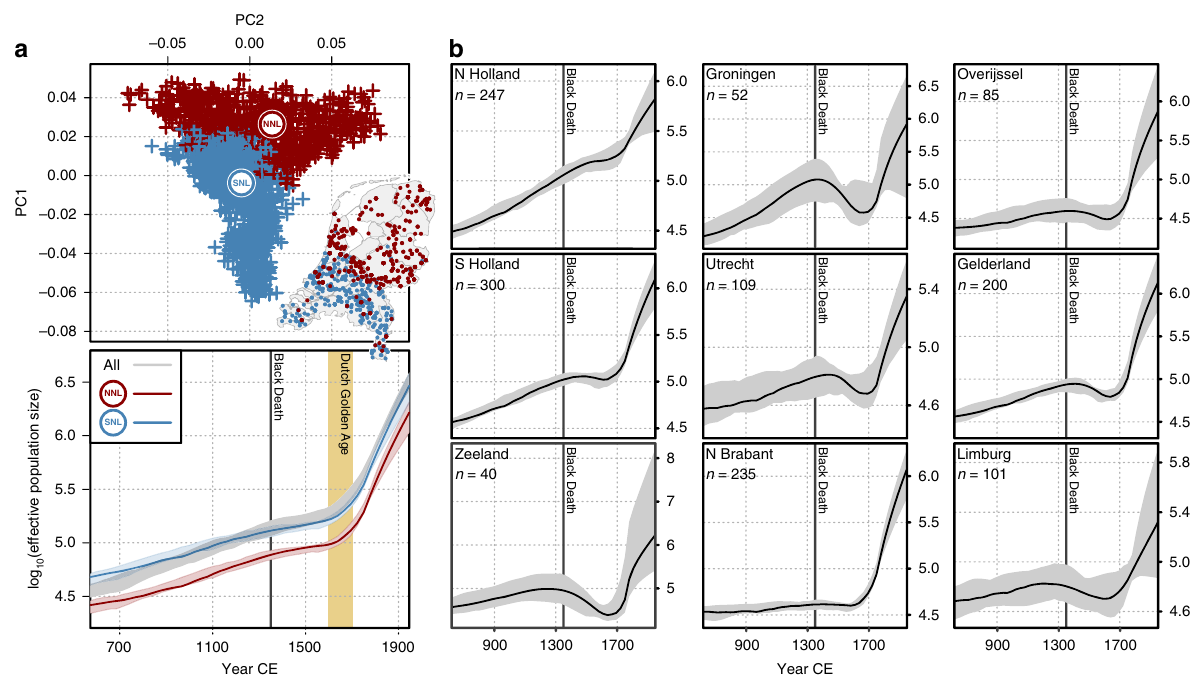
Fig. 4 Dutch effective population size over time. a Historical change in effective population size (N e ) over the past 50 generations for all Dutch individuals and subsets of northerners and southerners. The top plot shows the principal components of ChromoPainter coancestry coloured by the fi rst ( k = 2) fi neSTRUCTURE split, which separates the Dutch population into northern (NNL) and southern (SNL) genetic clusters; inset shows geographical distribution of these individuals. The bottom plot shows growth in effective population size countrywide or per fi neSTRUCTURE cluster over the past 50 generations. b Historical N e trajectories for individual Dutch provinces with more than 40 individuals sampled. For both ( a , b ), curves show point estimates for N e bounded by a 95% CI estimated from 80 bootstraps of the data (note this is not symmetrically distributed around the point estimates) and assume 28 years per generation and mean year of birth at 1946 CE. Map boundary data from the Database of Global Administrative Areas (GADM;